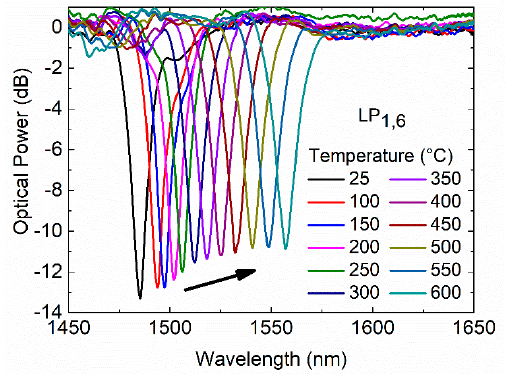
Figure 6. Transmission spectra of the cladding mode LP 1,6 of a 372.5 µm LPFG at annealing